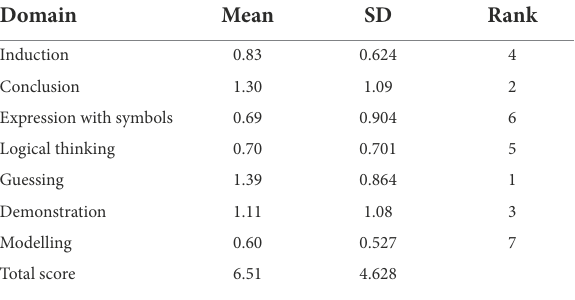
TABLE 3 Means and Standard Deviations of the female teachers of the first three grades scores on the mathematical thinking test. Domain